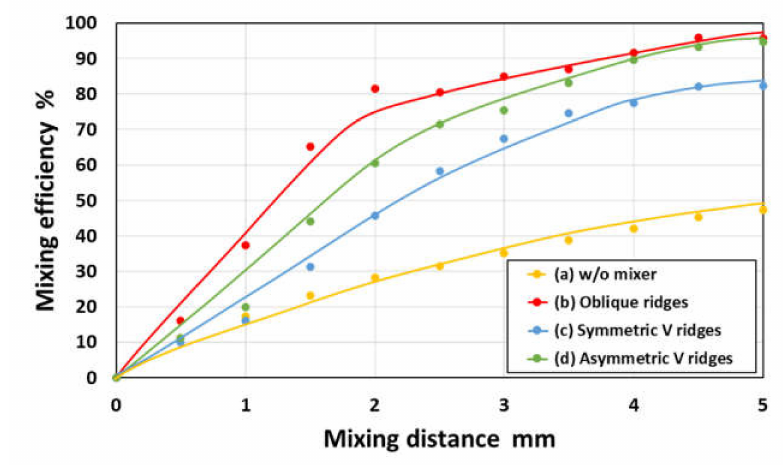
Figure 12. Simulation results showing the mixing e ffi ciency of three di ff erent chaotic mixers with periodic oblique, symmetric V-shaped, and asymmetric V-shaped ridges as a function of the mixing distance along the flow direction. For comparison, the data obtained in a rectangular microchannel without ridges is also plotted in the